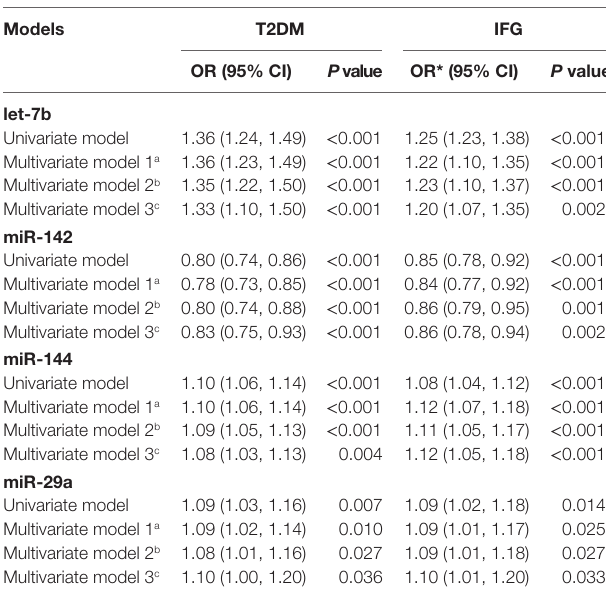
TaBle 6 | Univariate and multiple logistic regression analysis for the risk of type 2 diabetes mellitus (T2DM) and impaired fasting glucose (IFG).